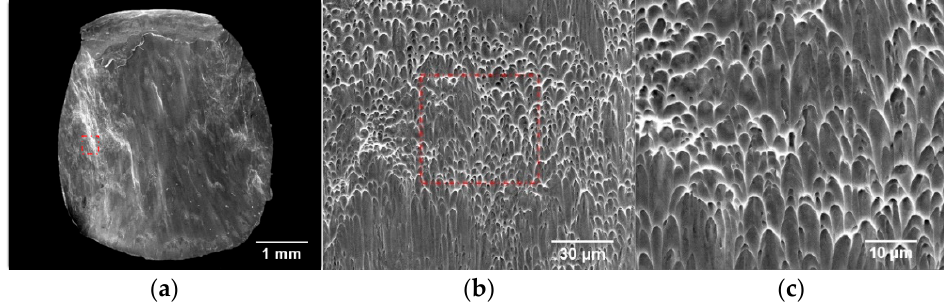
Figure 18. Fracture morphologies of specimen in scanning direction. ( a ) Full view of the fracture. ( b ) 2000× magnification. ( c ) 5000× magnification.